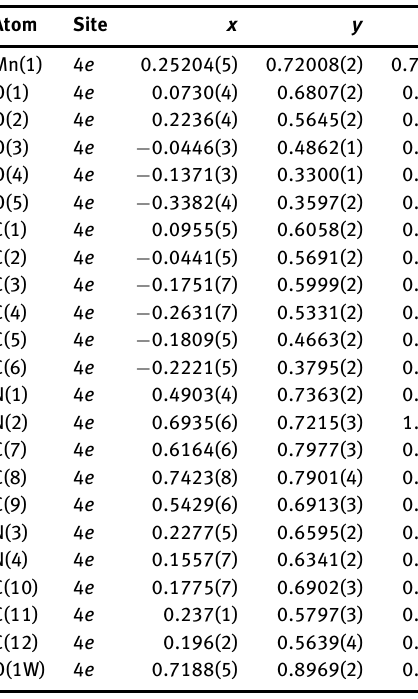
Table 3: Atomic displacement parameters (Å 2